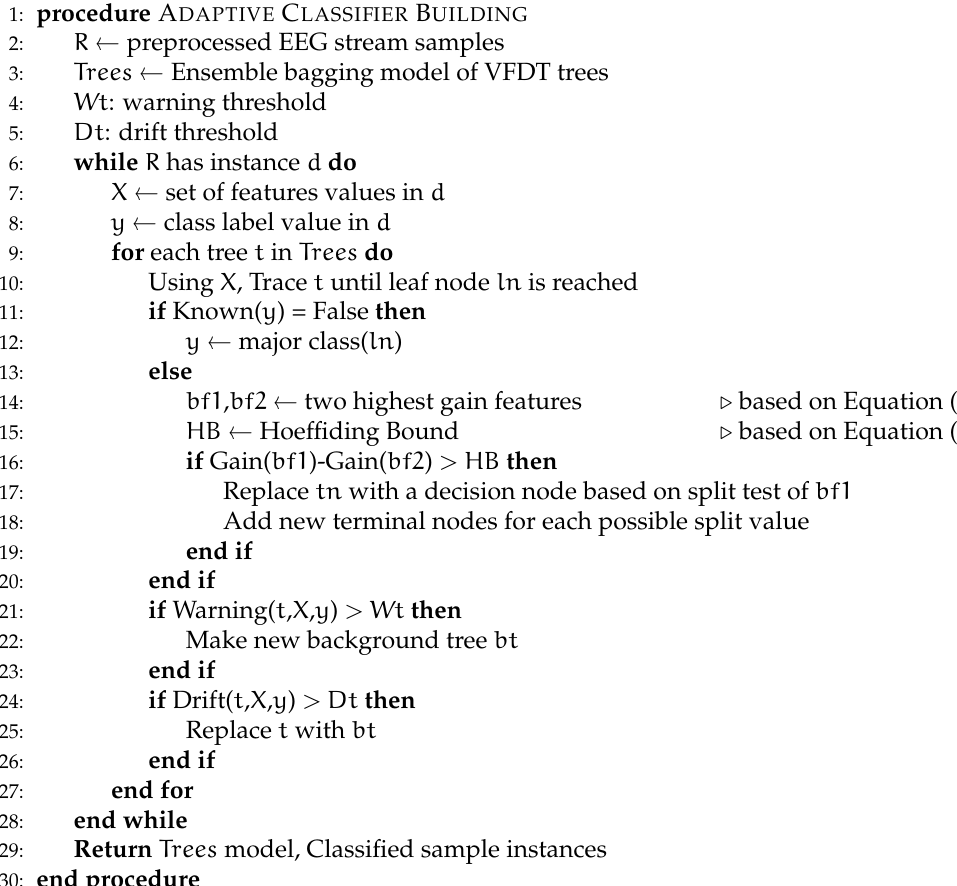
Algorithm 2 Adaptive Classification Model-Master